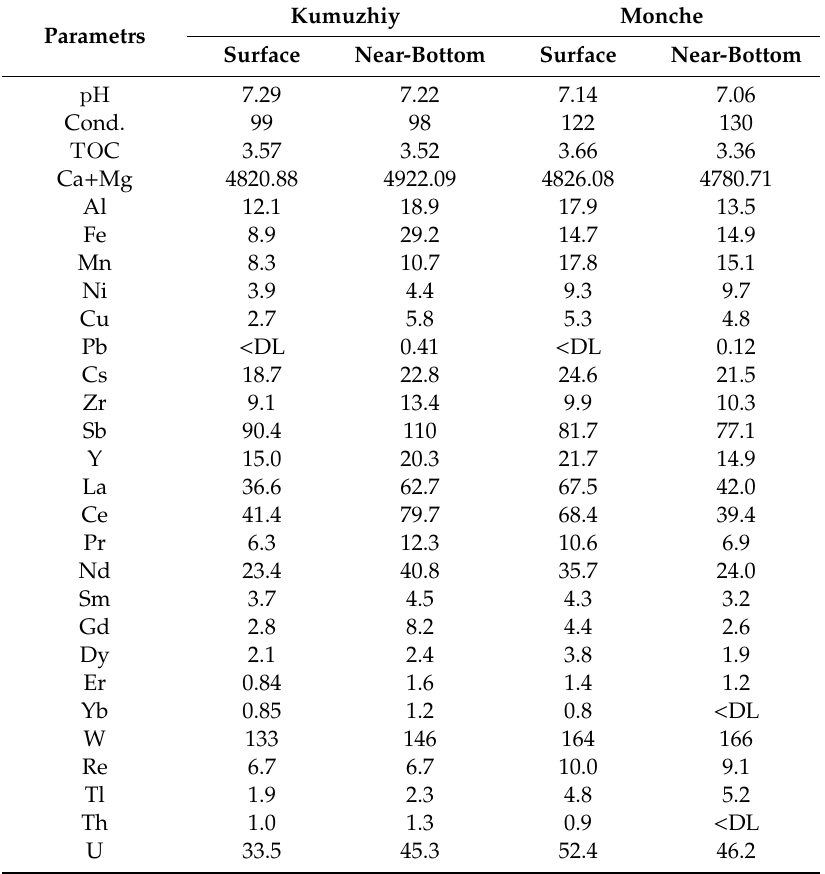
Table 1. Physicochemical parameters and element concentrations in samples (Al and Pb, µ g / L; other elements, ng /